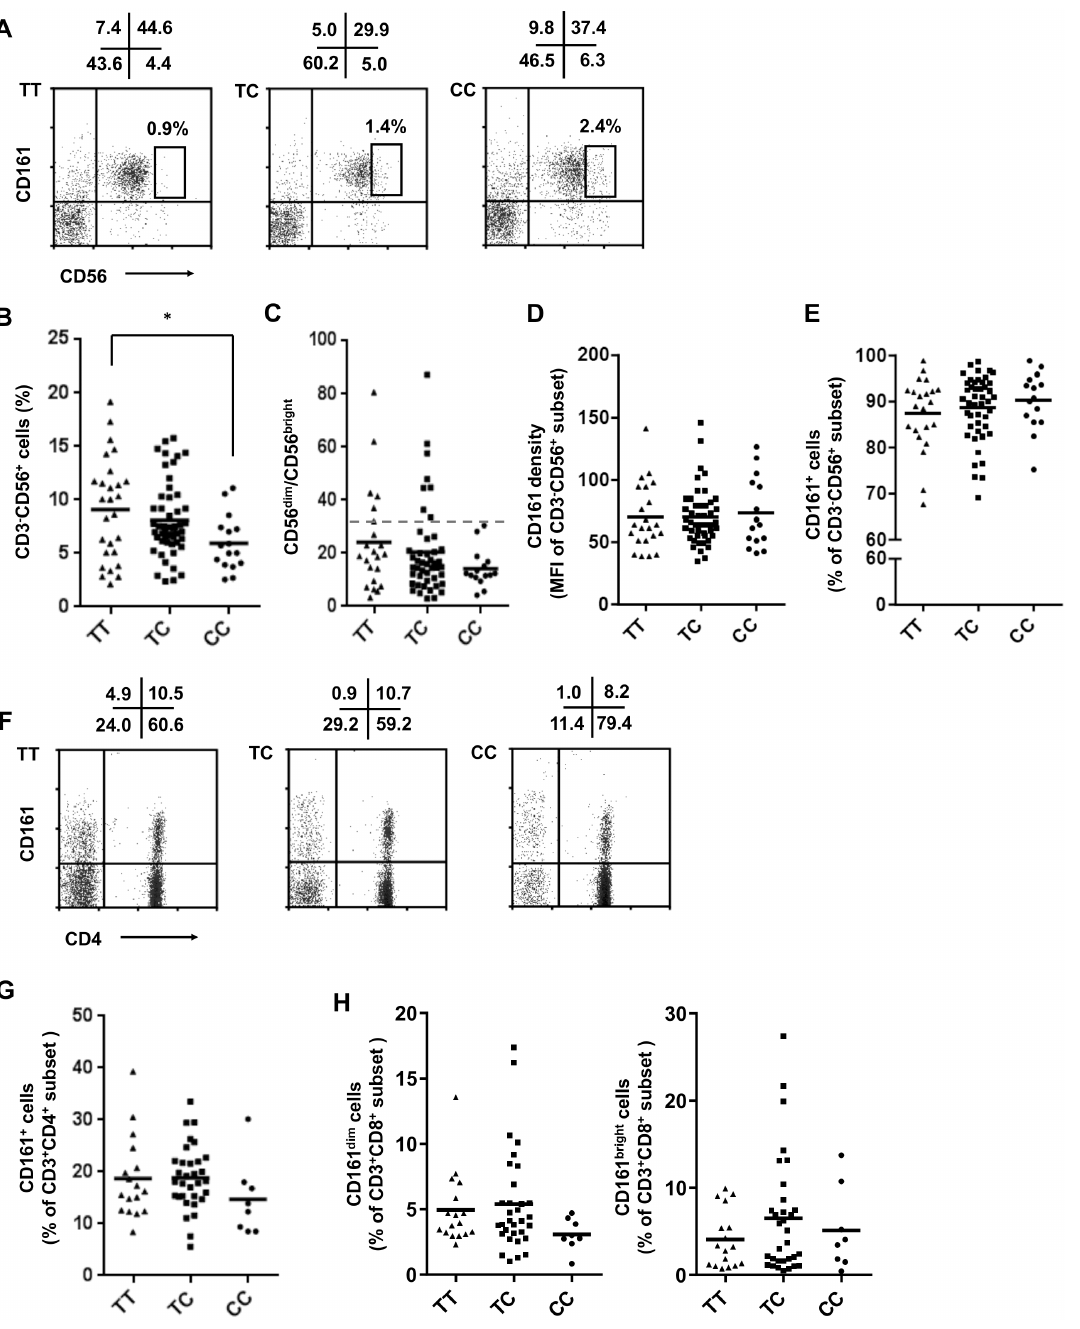
Fig 1. Assessment of lymphocyte subsets in individuals carrying different CD161 genotypes. PBMC were isolated and stained with the antibody combinations CD161/CD3/CD4 or CD161/CD3/CD56. Analyses were performed in gated viable lymphocytes as defined by forward- and side-scatter characteristics. (A) CD161 expression patterns on CD3 - NK cells. Representative dot-plots obtained after staining of cells from one TT, TC, and CC individual are shown. Boxes indicate the CD56 bright CD161 + CD3 - NK cell subset and the frequency. The numbers indicate % positive cells in each quadrant. (B) Decreased frequency of CD3 - CD56 + NK cells in CC carriers. PBMC from 27 TT, 51 TC, and 16 carriers of CC were analyzed. Results are expressed as % NK cells among gated lymphocytes; the mean value calculated for each cohort is indicated by the horizontal line; * p < 0.05 (ANOVA). (C) Ratios of CD56 dim to CD56 bright NK cells. The frequencies of CD56 dim CD161 + CD3 - and CD56 bright CD161 + CD3 - NK cells were determined in gated lymphocytes from 22 TT, 46 TC, and 15 carriers of CC. The horizontal broken line is an arbitrary cut-off value. (D) Level of CD161 expression. Data are expressed as mean fluorescence intensity/MFI on gated CD3 - CD56 + NK cells. (E) Proportion of NK cells co-expressing CD161. Data are expressed as % CD161 + cells in gated CD3 - CD56 + NK cells. (F) CD161 expression patterns on CD3 + T cells. The numbers indicate % positive cells in each quadrant. (G) Proportion of CD4 + T cells co- expressing CD161. (H) Proportion of CD8 + T cells co-expressing CD161 dim or CD161 bright .